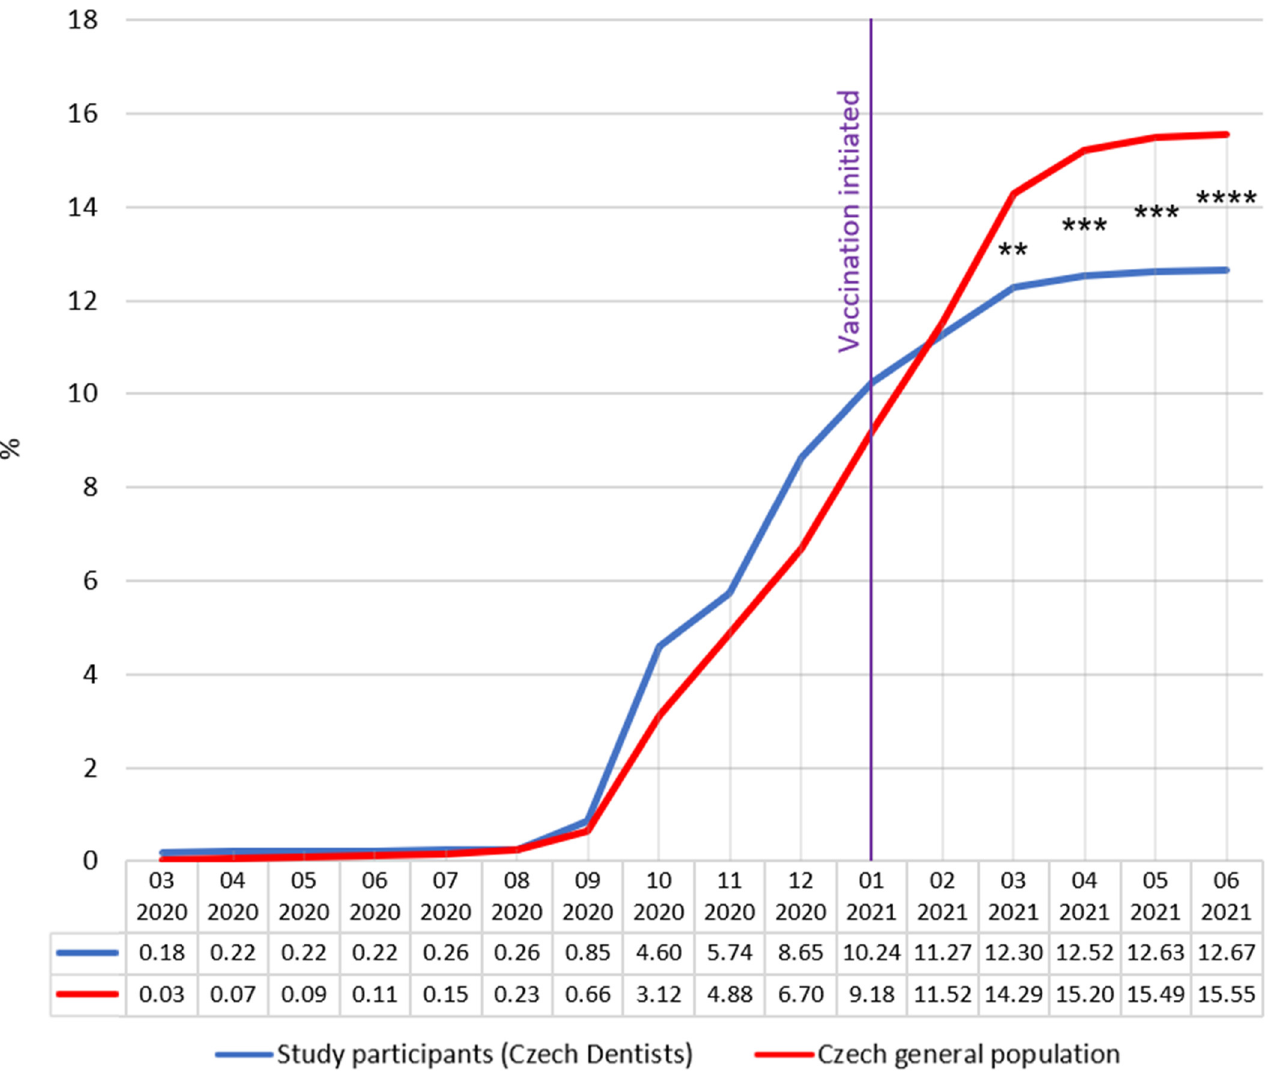
Figure 1. COVID-19 prevalence among Czech dentists and the Czech general population. The purple line indicates the time point when COVID-19 vaccination started. Chi-square test with Yates’ correction, ** p < 0.001, *** p < 0.001, **** p < 0.0001. As Czech dentists were highly motivated to get vaccinated against COVID-19, the vaccination rate increased sharply every month. In contrast, vaccination among the general population increased very slowly as restrictions on access to vaccination limited it and only selected most-at-risk groups were vaccinated [14]. An increase in the vaccination rate of the general population in June 2021 is associated with an end of most of the restrictions during this month. By 30 June 2021, out of the 2716 dentists involved in the study, 2016 (79.53%) stated they were fully vaccinated against COVID-19. By the same time, a total of 3,308,807 (30.95%) individuals of the Czech general population were fully vaccinated against COVID-19. The difference in vaccination between dentists and the general population was statistically significant (January–June 2021: p < 0.0001). The results are presented in Figure